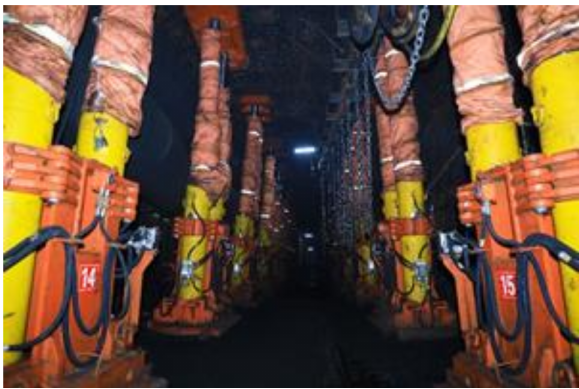
Figure 14. Support effect of the roadway surrounding